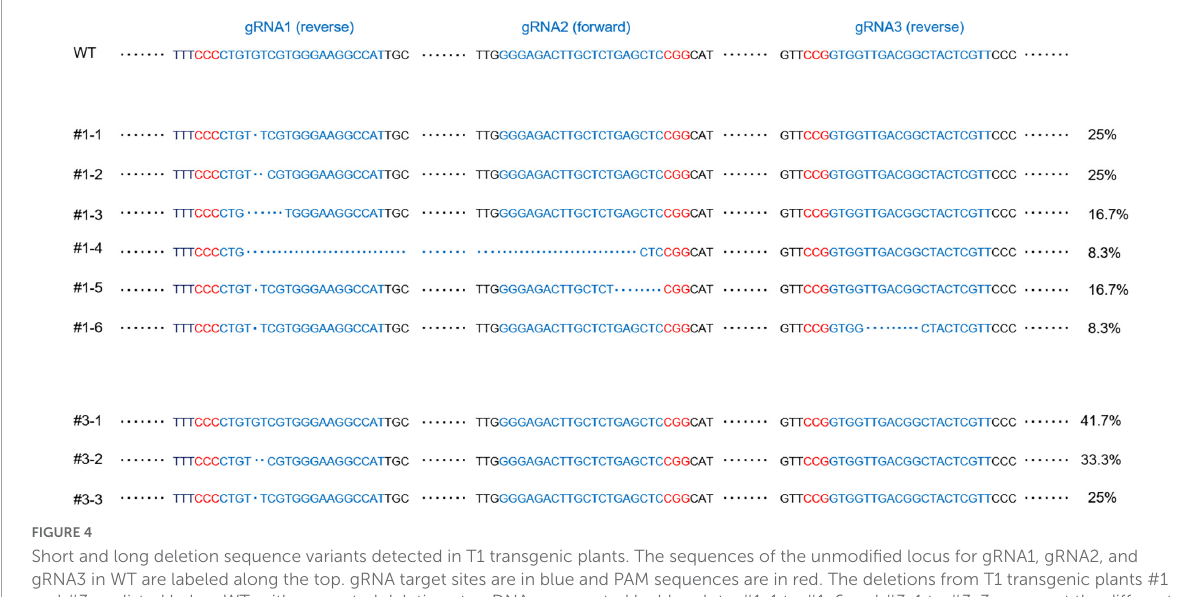
These #4-2 and #5-7 ARP2 CRISPR-edited lines, in which Cas9/gRNA sequences are deleted, are suitable for the functional analysis of ARP2 because Cas9 nuclease activity is not present anymore in the background to create additional edited